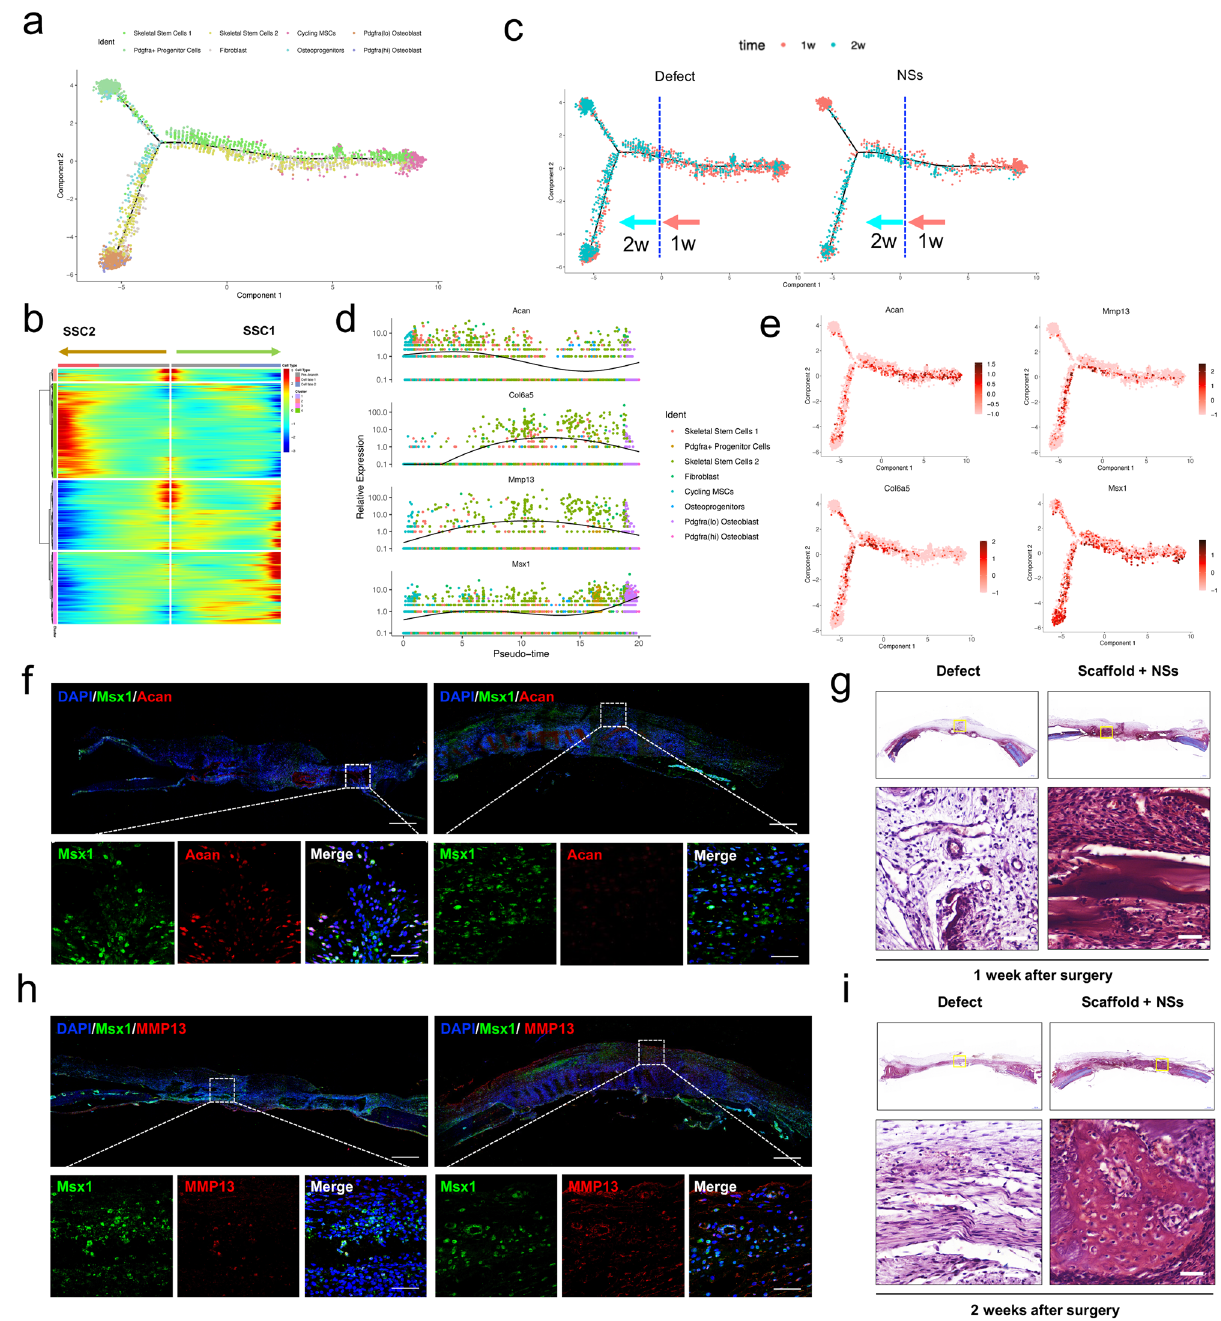
Fig. 6 | In situ expansion of Msx1 + SSCs subset promoted ef fi cient bone regeneration partially through endochondral ossi fi cation. a Trajectory of dif- ferentiation from cycling MSCs to both SSC1 and SSC2 lineages predicted by Monocle 2. b Heatmap of gene expressions in subsets ordered by pseudotime of two differentiation trajectories in a . c Distribution of cells on both the differ- entiation trajectories from Defect and NSs groups showing a featured change dominated at 1 week and 2 weeks after surgery, respectively. d Relative expression levelofanabolicandmetabolicgenes(Acan,Col6a5,Mmp13)ofcartilageandMsx1 gene along the whole pseudotime. e Expression of the above chondrocyte-speci fi c genes (Acan, Col6a5, Mmp13) and SSC2 marker gene (Msx1) visualized on